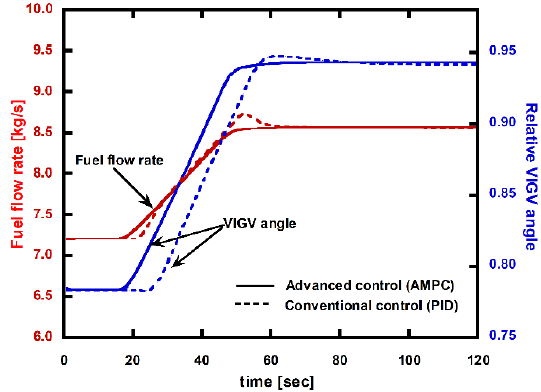
Figure 22. Simulated variations in fuel flow rate and VIGV angle with increasing load (ramp rate: 60 MW/min).